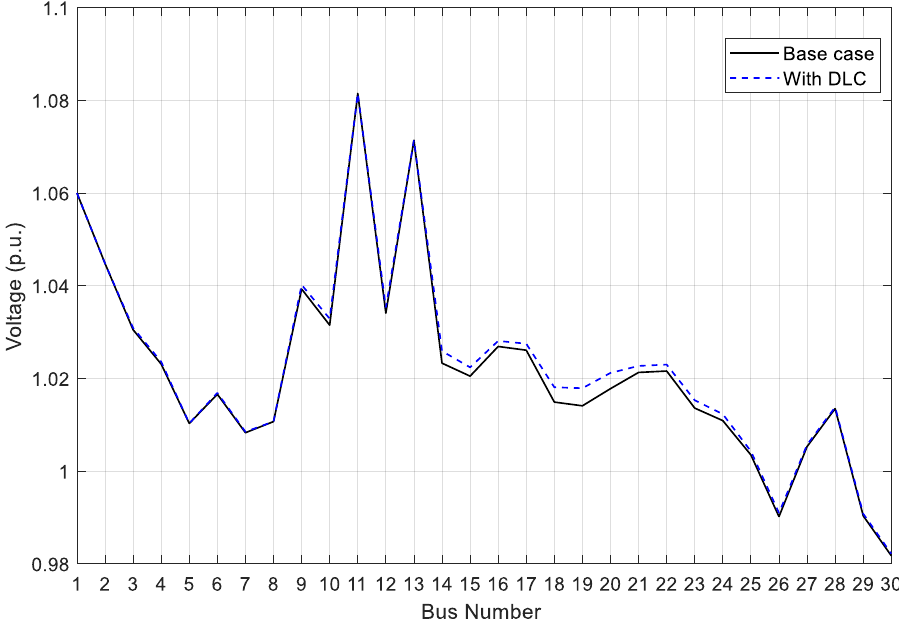
Figure 11. Case IV: Comparison of the voltage profile without DLC (Base case) and with DLC. Table 4. Case IV: Active power with/without DLC.